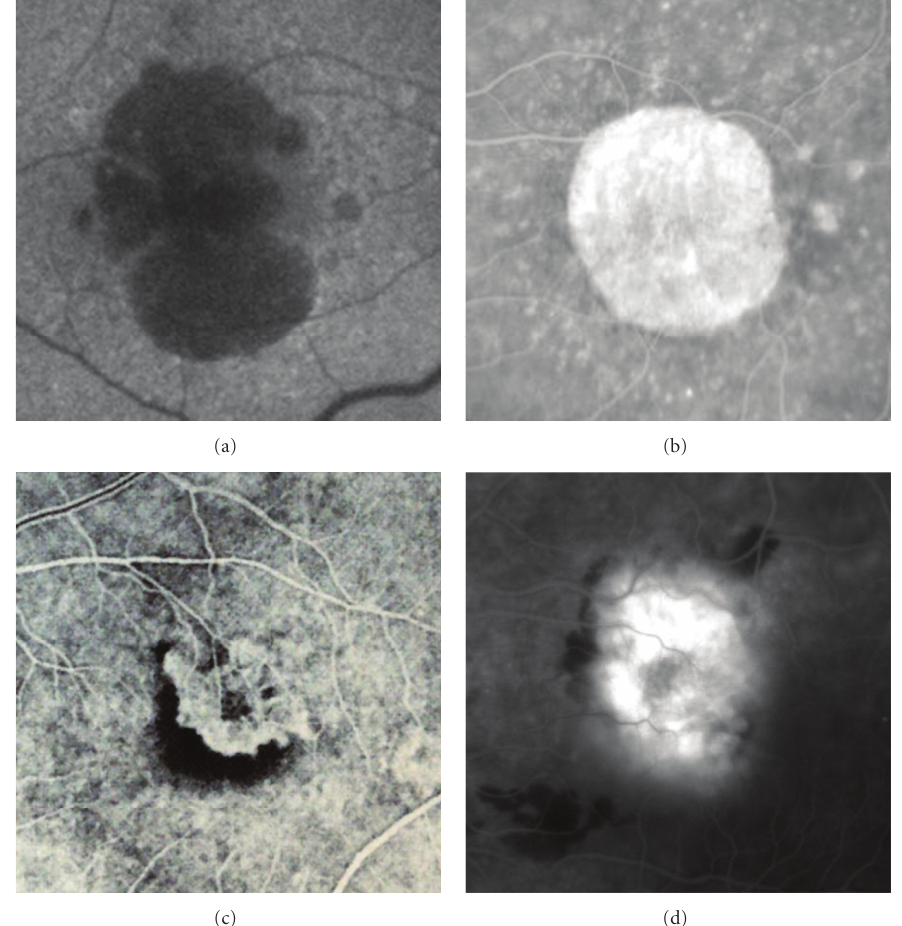
Figure 4: Advanced forms of age-related macular degeneration. (a) Autofluorescent retinography and (b) fluorescein angiography of two di ff erent cases of severe central geographic atrophy; in these eyes, the best-correct visual acuities were, respectively, 20/125 and 20/160 (Snellen equivalent). (c) Early and (d) late fluorescein angiograms of two di ff erent cases of subfoveal choroidal neovascularization; in both these eyes, the best-correct visual acuity was 20/200 (Snellen